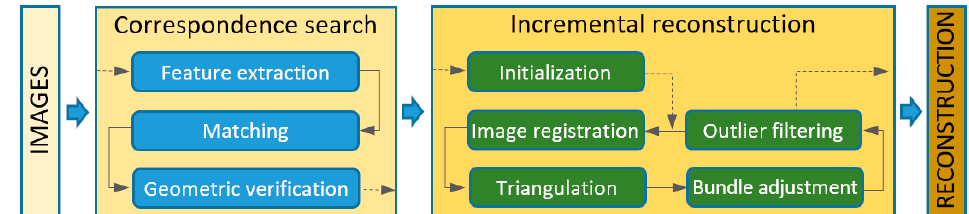
Figure 2. The process of operation of the software for the SfM method.